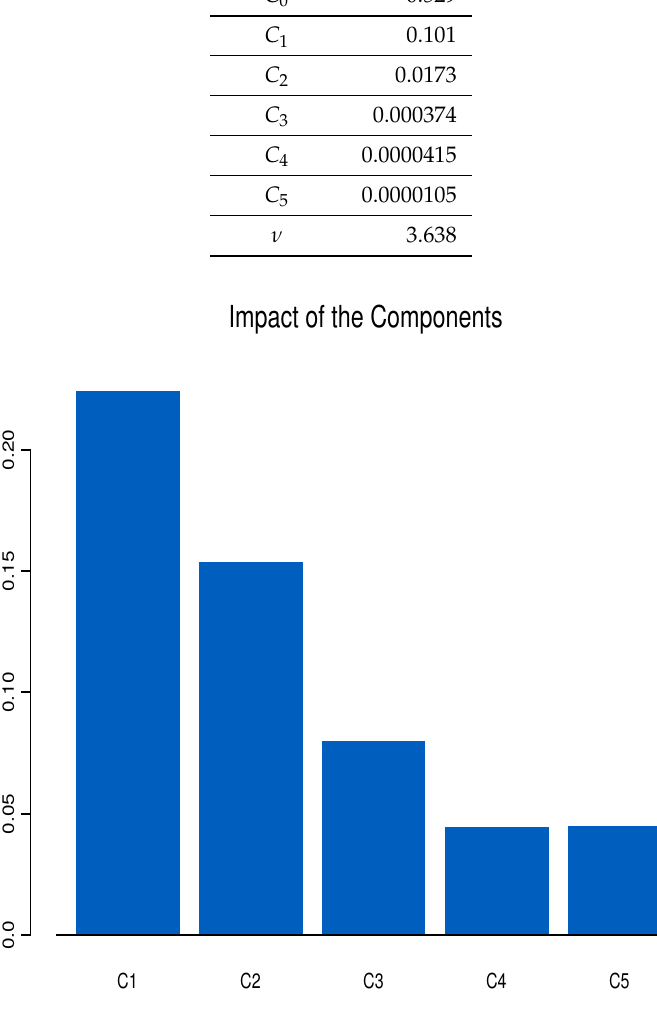
Figure 5. Impact of the components estimated by maximum